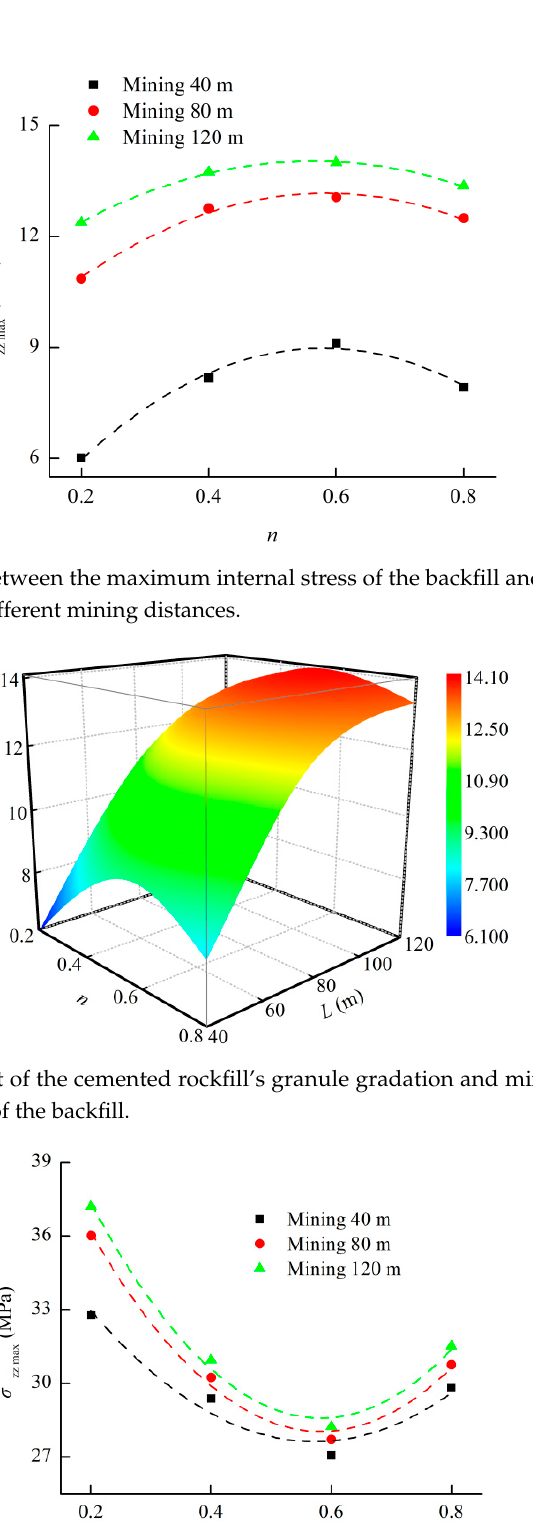
Figure 18. Coupling effect of the cemented rockfill’s granule gradation and mining distance on the maximum internal stress of the backfill.